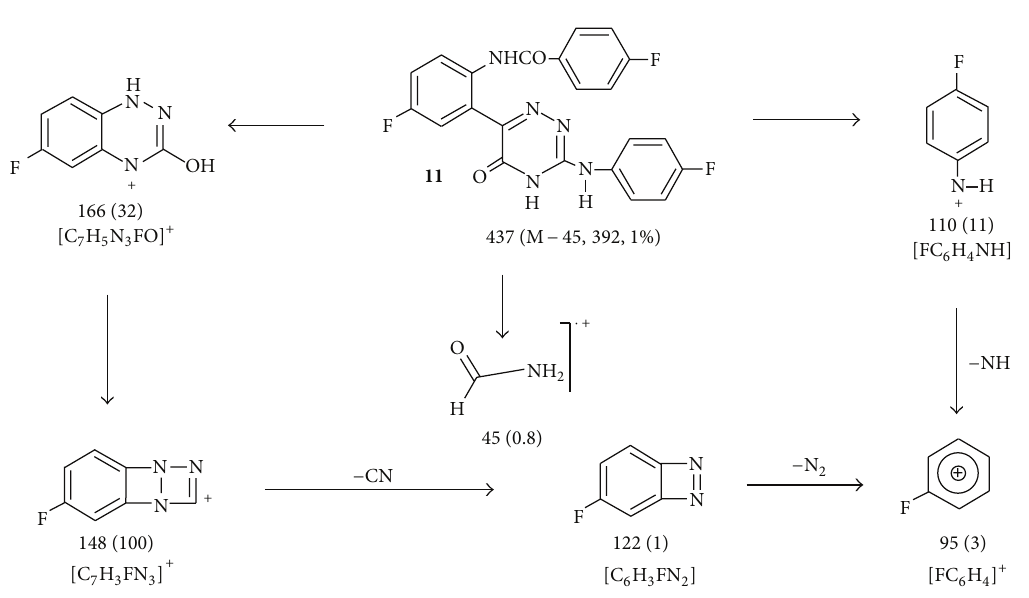
Scheme 9: Mass fragmentation pattern of compound 11